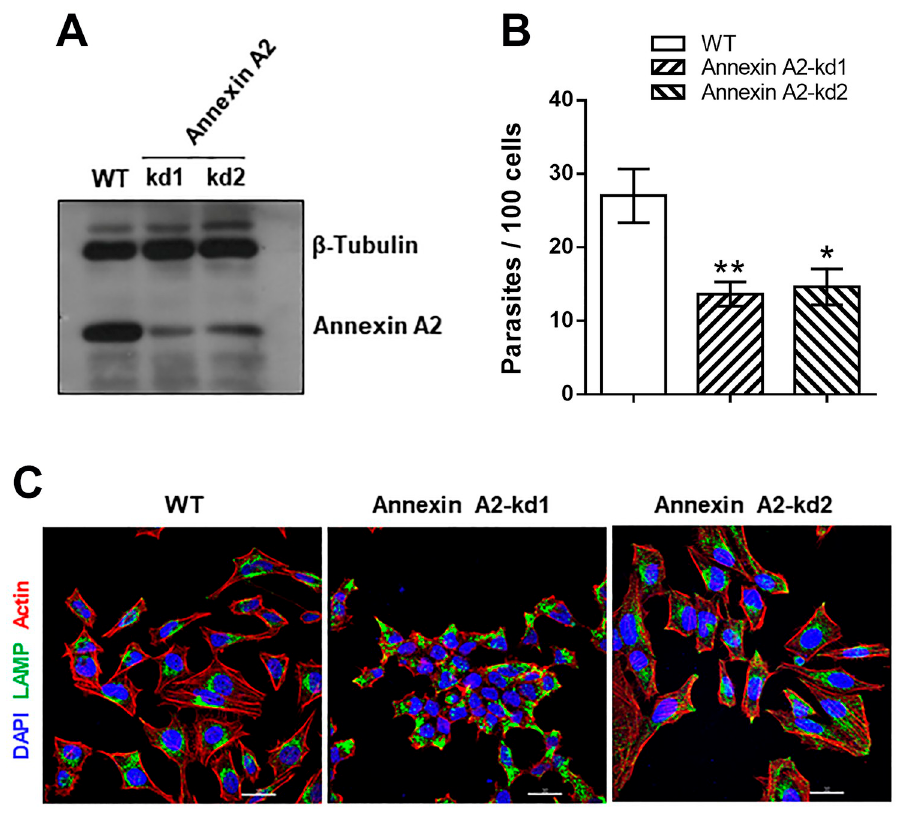
Fig 4. Increased resistance of annexin A2-depleted cells to G strain MT invasion. ( A ) HeLa cells were submitted to lentiviral transduction for annexin A2 knockdown (kd) and analyzed by western blotting. Note the depletion of annexin A2 in two independent cell lines. ( B ) HeLa cells depleted in annexin A2 and WT cells were incubated for 1 h with G strain MT. The amounts of intracellular parasites are shown as means ± SD of three independent assays performed in duplicate. MT invasion was significantly diminished in cells deficient in annexin A2 ( � P < 0.01, �� P < 0.005). ( C ) Non infected annexin A2-deficient and WT cells were analyzed by immunofluorescence, to